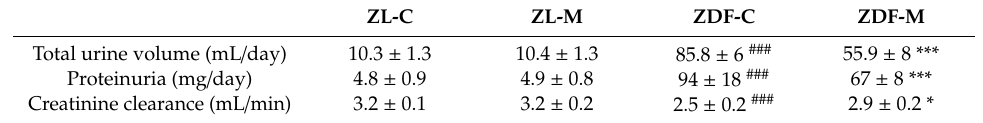
Table 1. E ff ects of melatonin on urinary and serum parameters indicators of nephropathy (urinary flow, proteinuria, and creatinine clearance) on ZL, Zücker lean rats ( n = 8); ZL-M (ZL—melatonin treated) ( n = 8), ZDF, Zücker diabetic fatty rats ( n = 8), and Zücker diabetic fatty-M (ZDF-melatonin treated) ( n = 8) rats, after 16 weeks of treatment.